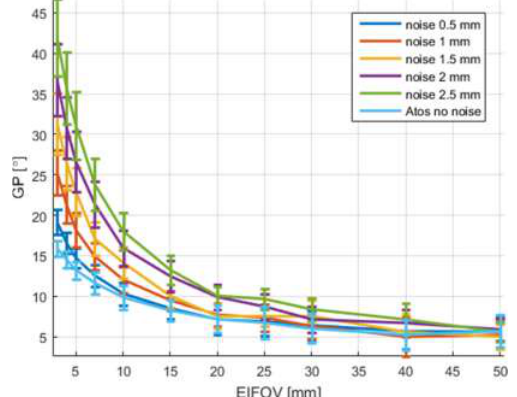
Figure 7. GP of noisy surfaces (GP n ) versus EIFOV.